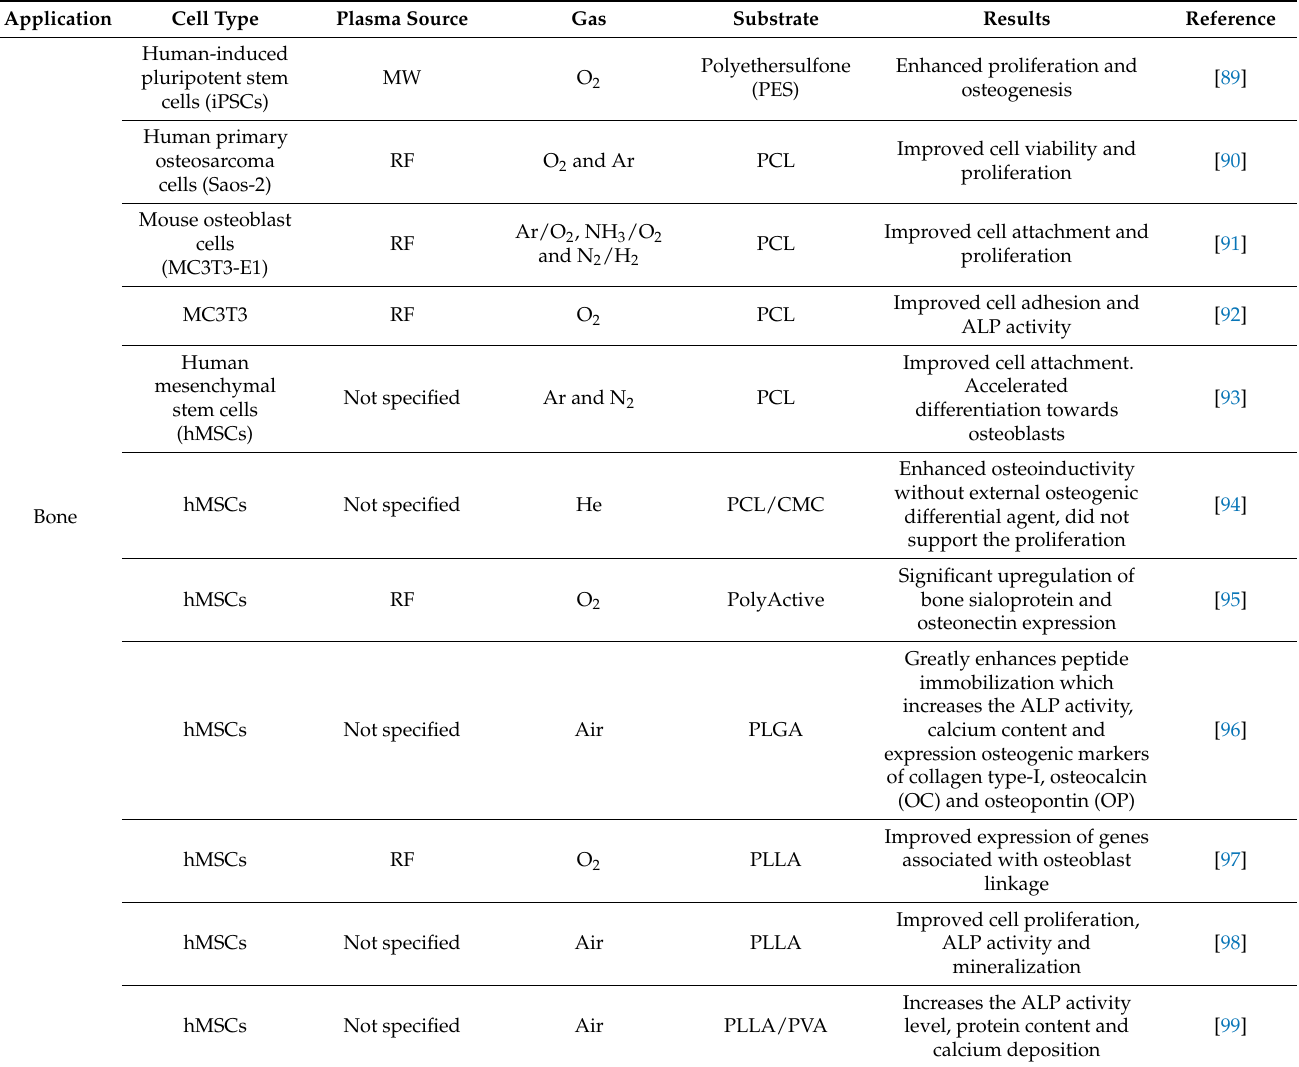
Table 1. In vitro cell studies on plasma-activated nanofibrous